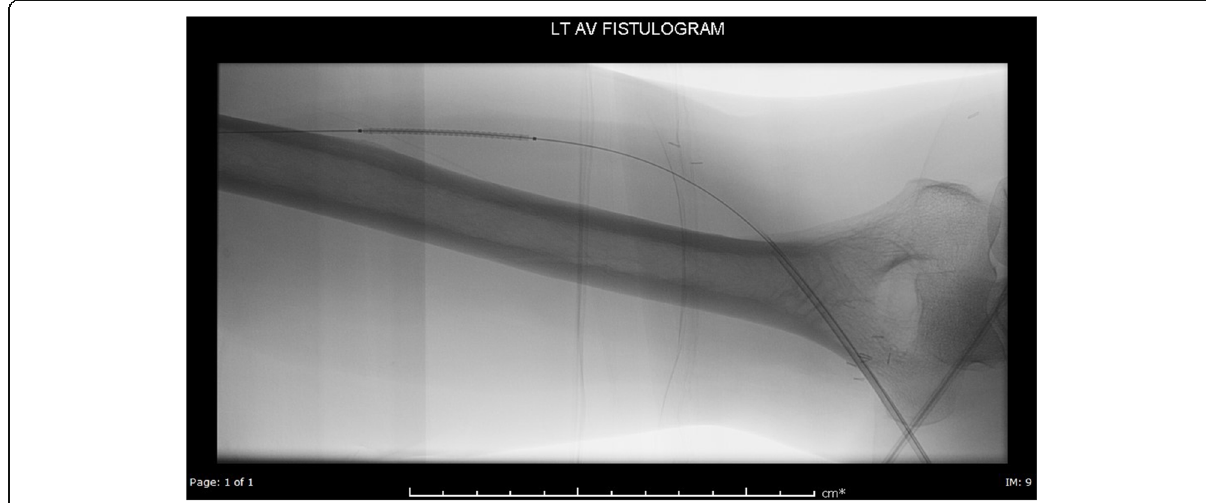
Fig. 2 Pre stent (Viabahn 6 mm diameter) deployment